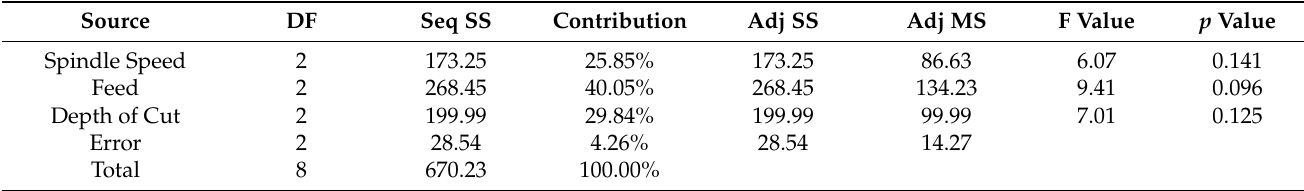
Table 10. Analysis of variance for transformed response for machining time.